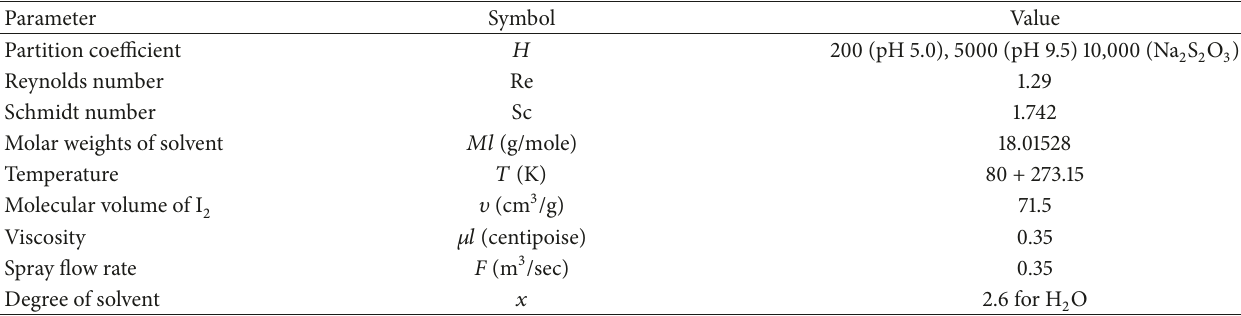
Table 4: Numerical data for spray removal term [31, 35,